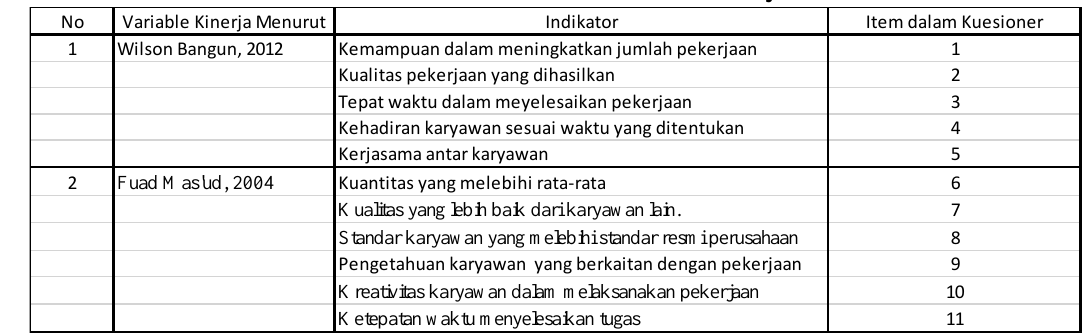
Tabel 4 Indikator untuk Variabe